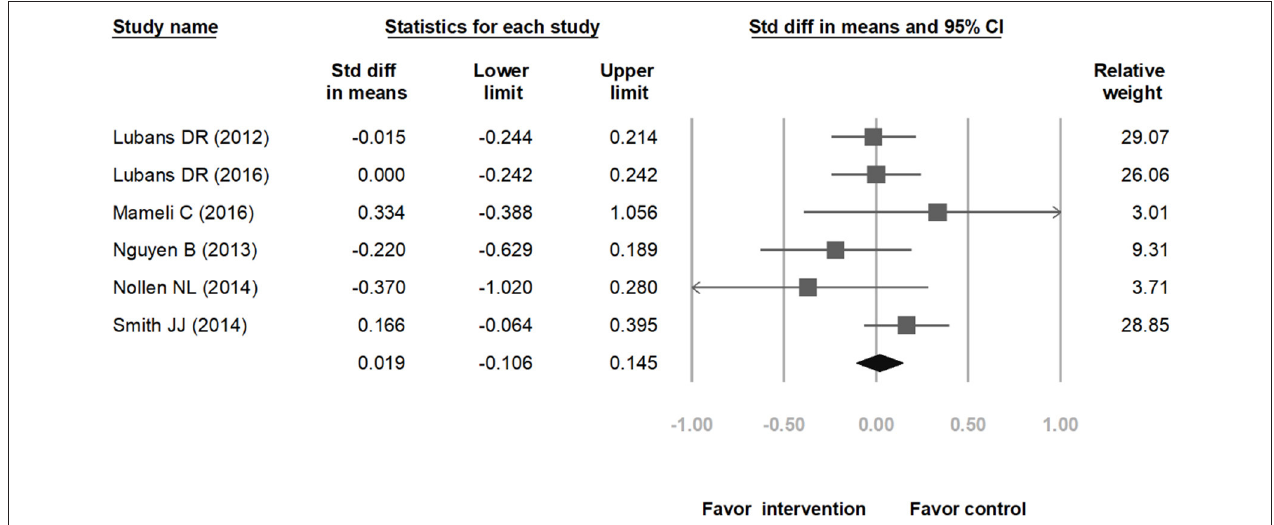
FIGURE 4 | The weight loss effect between the intervention and control groups of the non-ethnic Chinese